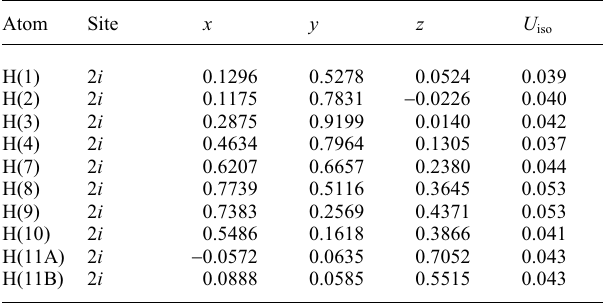
Table 2. Atomic coordinates and displacement parameters (in Å 2 )